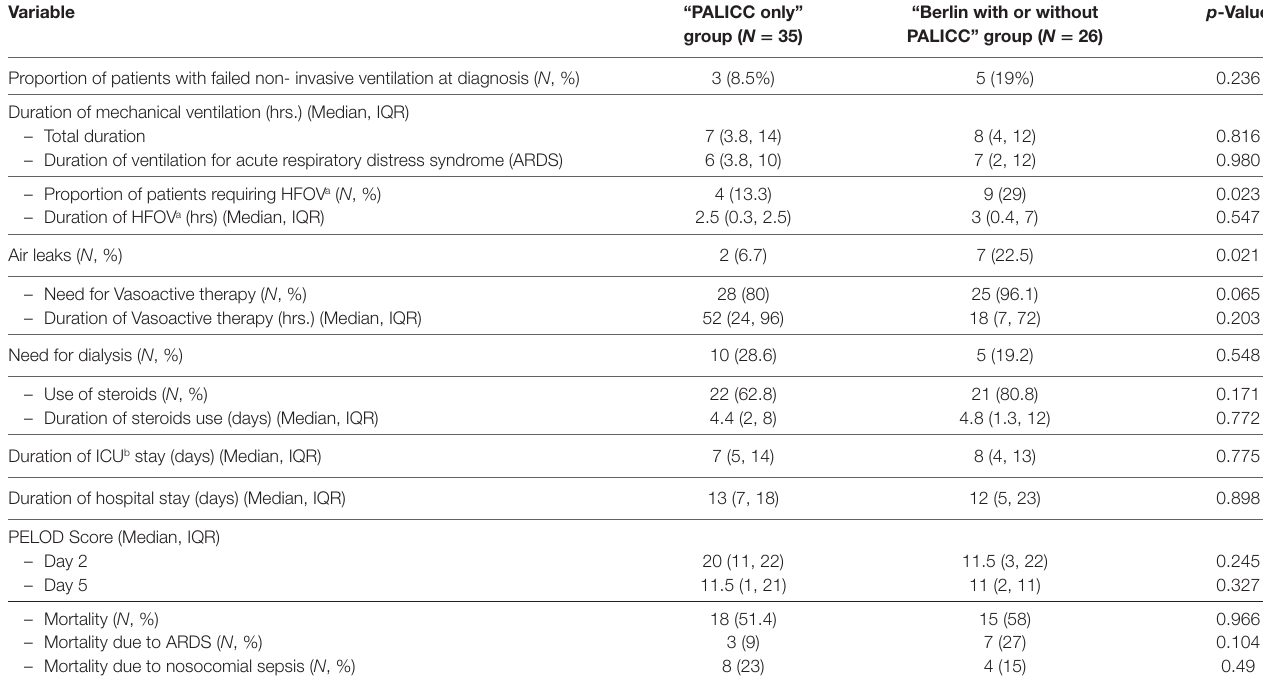
“Berlin with or without p -Value group ( N = 35) Palicc” group ( N = 26)